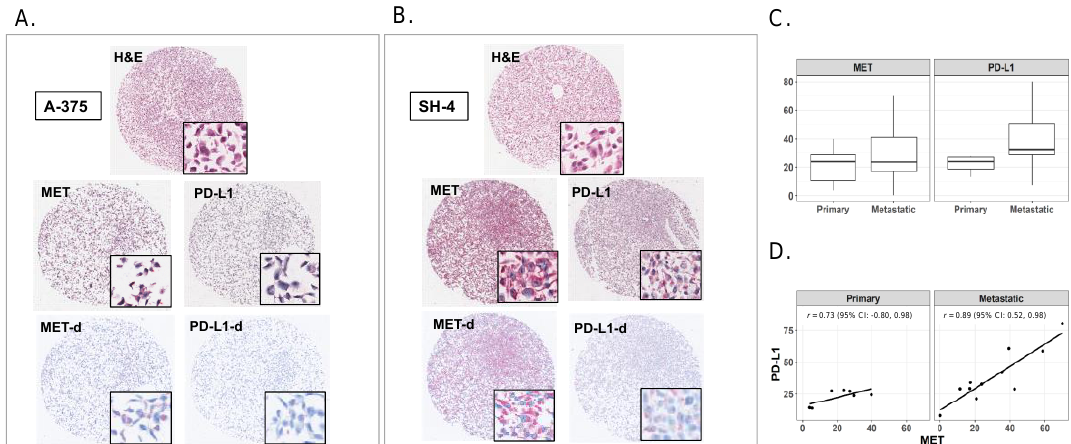
Figure 1. Histopathology images of MET and programmed death-ligand 1 (PD-L1) expression levels in a representative primary melanoma (A-375, panel A ) and a metastatic melanoma (SH-4, panel B ) cell lines. Hematoxylin and eosin (H&E), MET, and PD-L1 immunostained slides from the cell microarray (CMA) are represented (full cores, 4×; insets, 40×), as well as color-deconvolved images for MET (MET-d) and PD-L1 (PD-L1-d). Boxplot with the box representing the interquartile range and a dark line representing median MET and PD-L1 in seven primary melanomas and 11 metastatic melanomas ( C ). Correlation of MET and PD-L1 in primary and metastatic cell lines, with Pearson’s r values and 95% confidence interval ( D ).